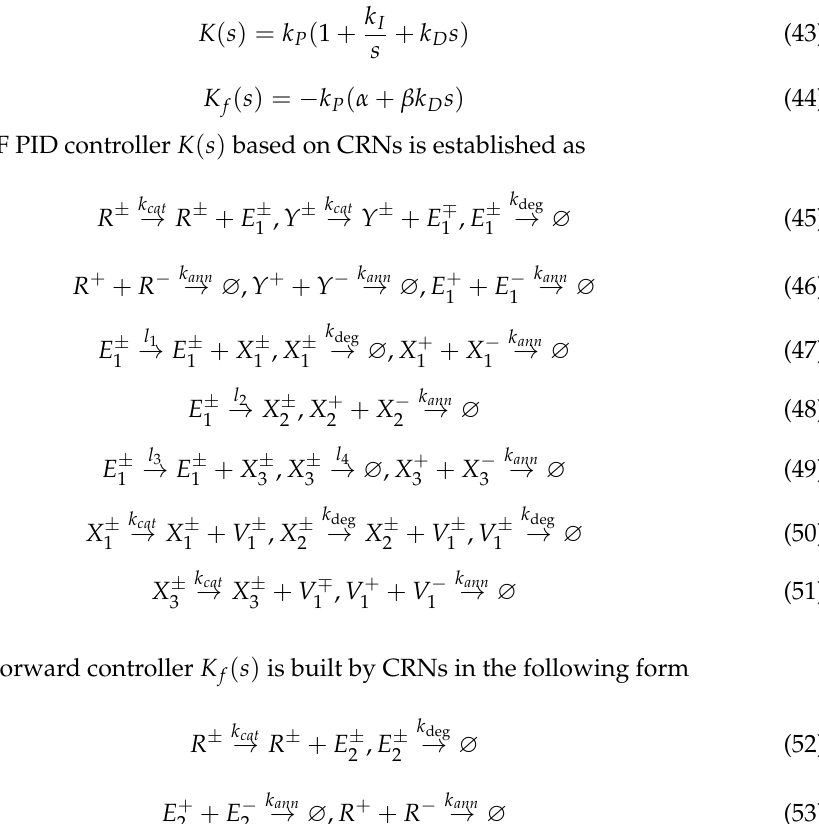
Figure 7. 2DOF PID control system 3